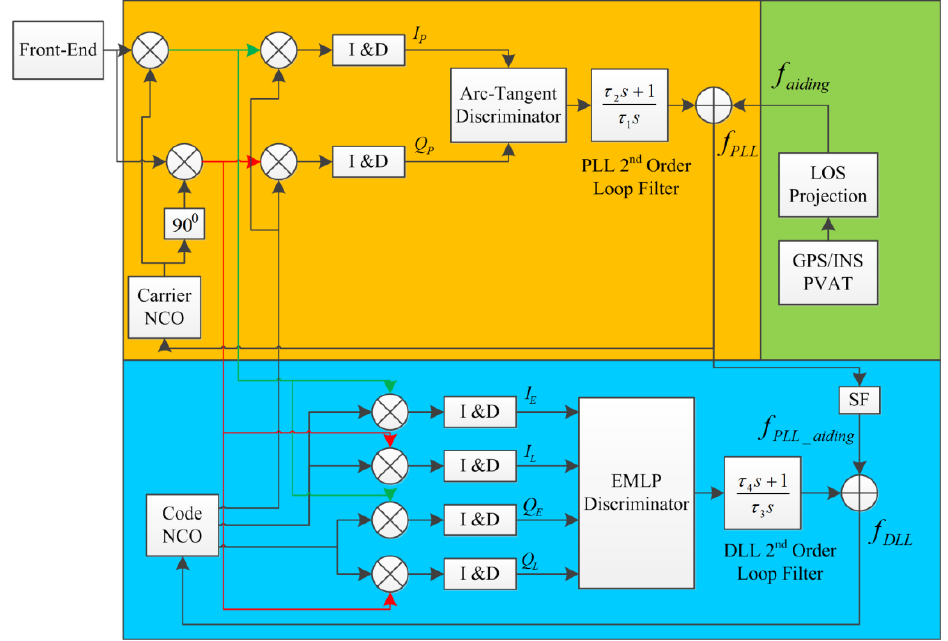
Figure 2. GPS-assisted PLL and DLL